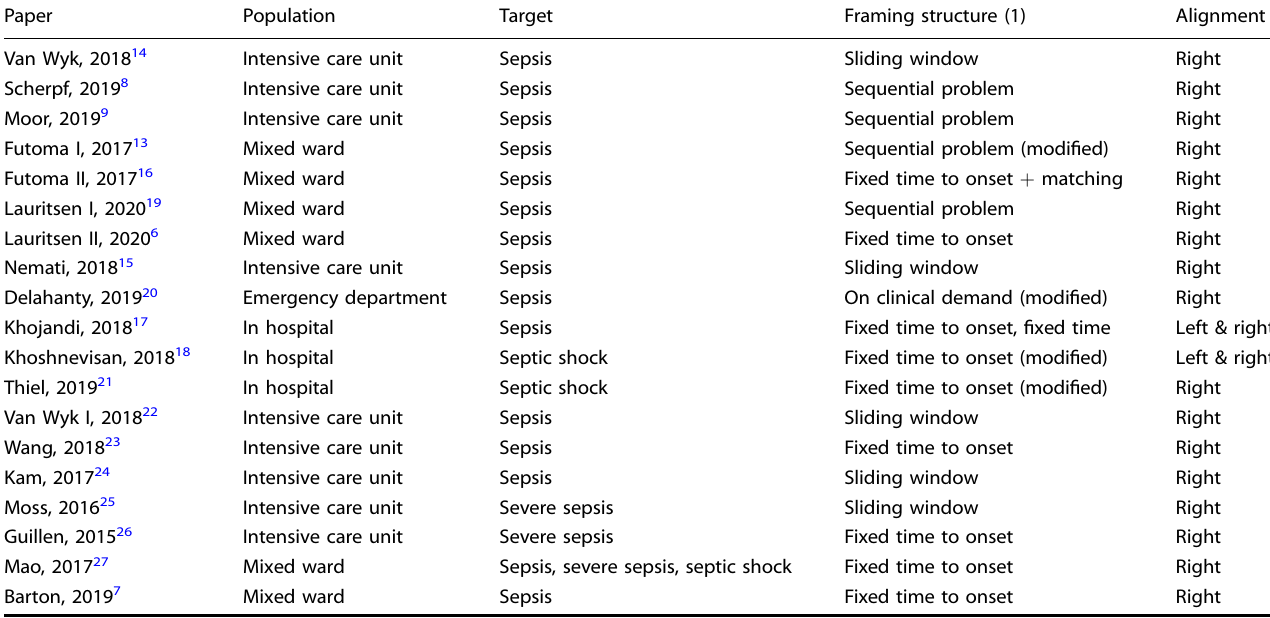
Table 1. Framing structures in related